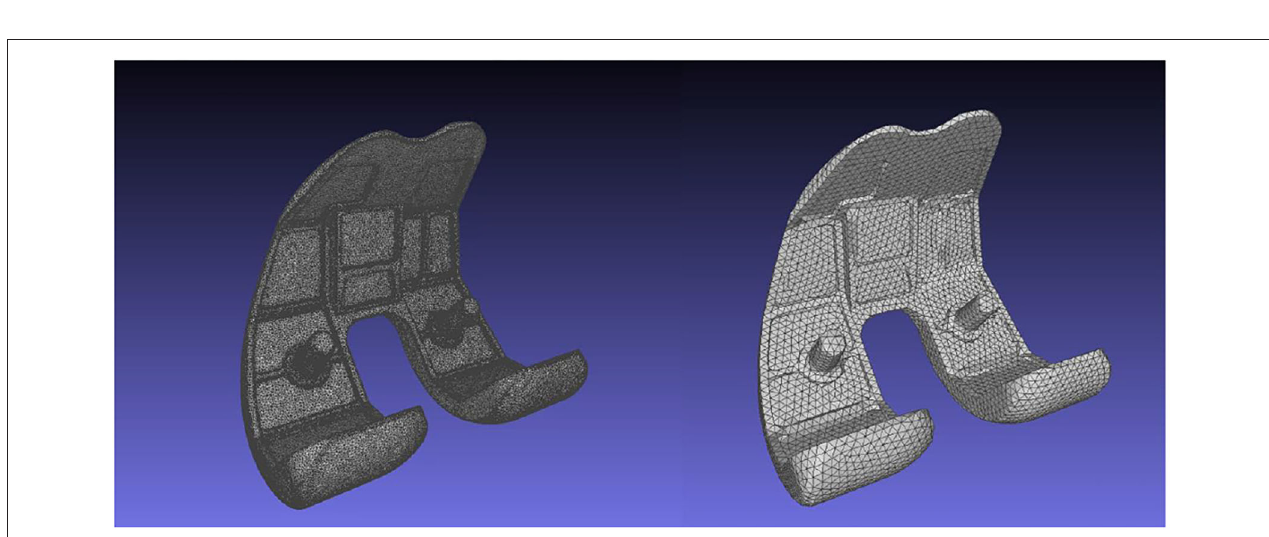
FIGURE 5 | Femoral component’s mesh before (left, 99.995 vertices), and after (right, 6.000 vertices) the Instant Meshes algorithm.